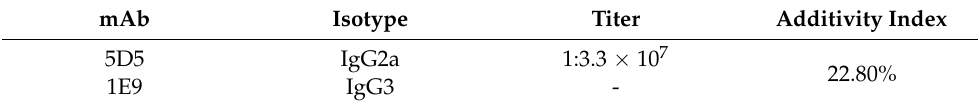
Figure 3. Identification of TgROP14-5D5 mAb and TgROP14-1E9 mAb. ( a ) Western blot analysis of two mAbs reacted with T. gondii lysate antigen (TLA). Total soluble proteins of T. gondii tachyzoites (10 µ g) were loaded into each lane. The primary antibodies were mAb 1E9 and 5D5 to TgROP14. M: protein marker. ( b ) SDS-PAGE analysis of two mAbs before and after purification. Left: 1E9 mAb after purification and before purification; right: 5D5 mAb after purification and before purification; M: protein marker. ( c ) IFAT of two mAbs. Vero cells were used after infection with T. gondii tachyzoites for 24 h. The primary antibodies and Alexa Fluor 488-conjugated secondary antibodies for labeling were used in 1:1000 dilution. Confocal micrographs are shown. Table 1. Immunological characteristics of TgROP14-5D5 mAb and TgROP14-1E9 mAb. mAb Isotype